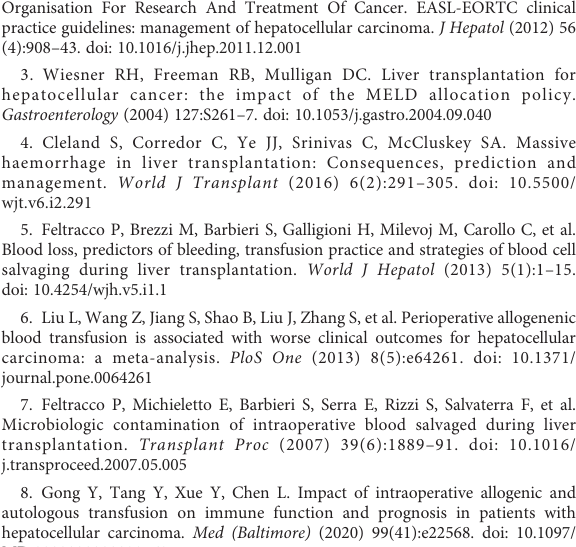
SUPPLEMENTARY FIGURE 2 Funnel plot of publication bias test for RR outcomes. Upper left, 1-year RR; Upper right, 3-year RR; Lower left, 5-year RR; Lower right, 7-year RR. SUPPLEMENTARY FIGURE 3 Funnel plot of publication bias test for OS outcomes. Left, 1-year OS; Middle, 3-year OS; Right, 5-year